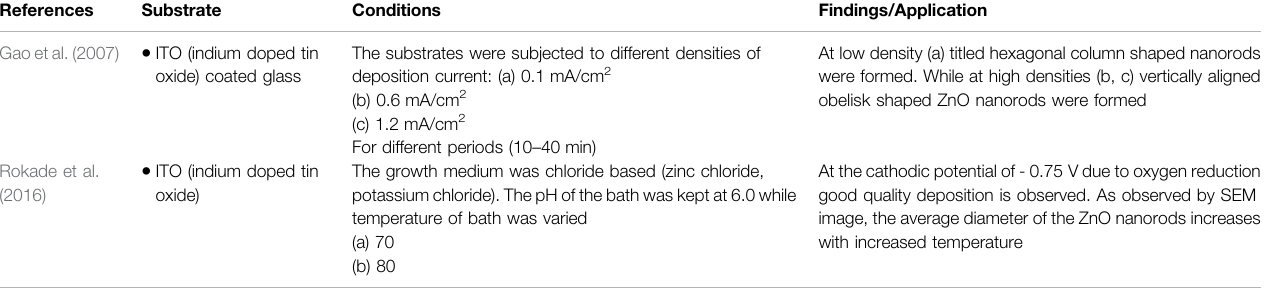
TABLE 3 | Summary of the nanorods synthesized by electrodeposition.